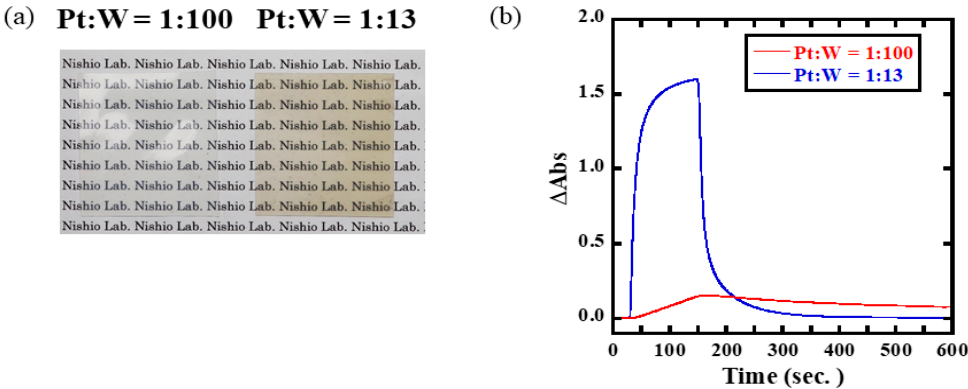
Figure 3. Dependence of H 2 response on the amount of the Pt catalyst in Pt/WO 3 nanoparticles. ( a ) Typical image of Pt/WO 3 nanoparticle-dispersed membranes. ( b ) H 2 response measured at 800 nm.